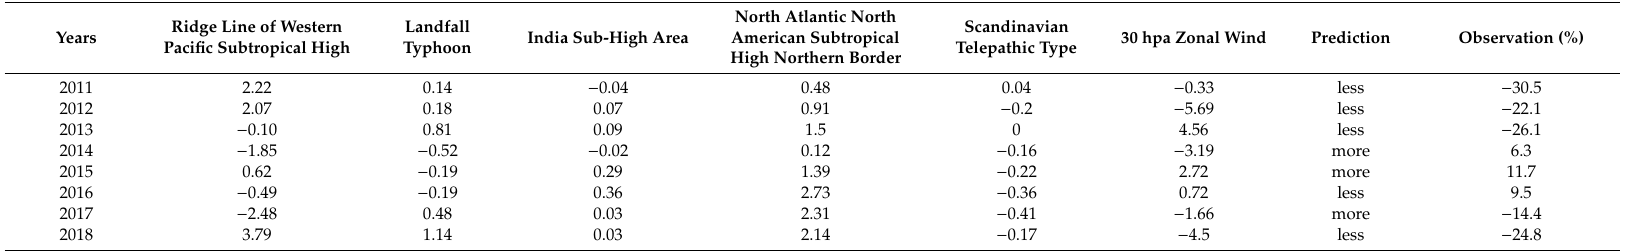
Table 2. Di ff erent circulation index anomaly, precipitation prediction and observation from 2011 to